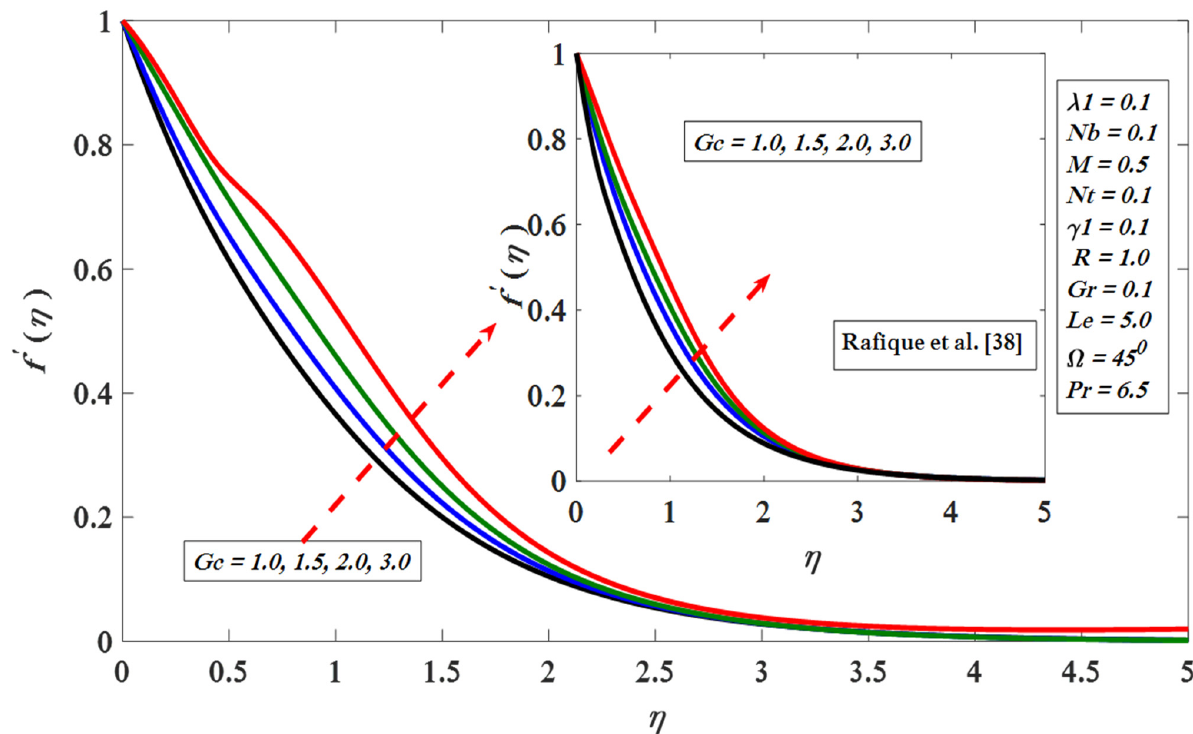
Figure 4. Velocity profile versus Gc .